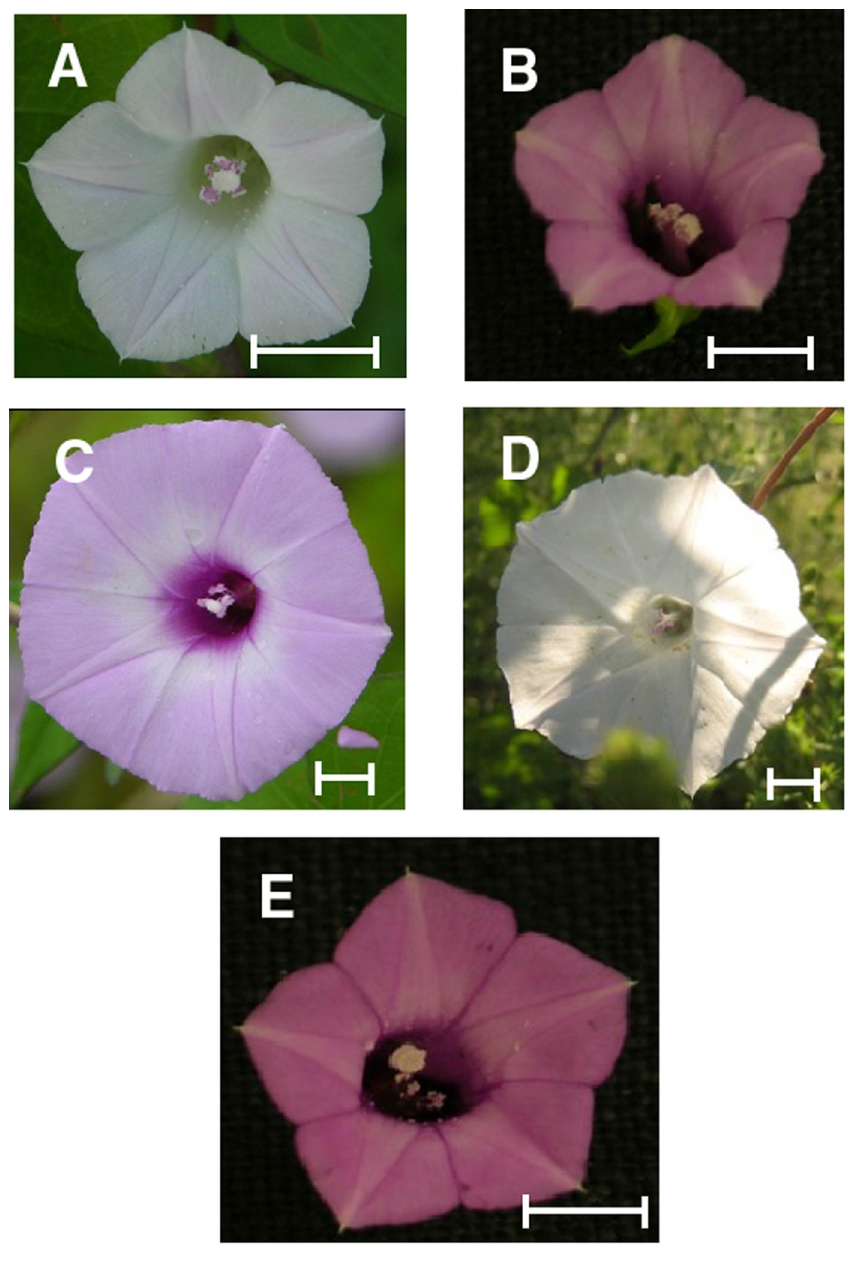
Fig 1. Flowers of species used in this study. A:white Ipomoea lacunosa . B: purple I . lacunosa . C: purple I . cordatotriloba . D: white I . cordatotriloba . E: I . leucantha . Scale bar indicates 5